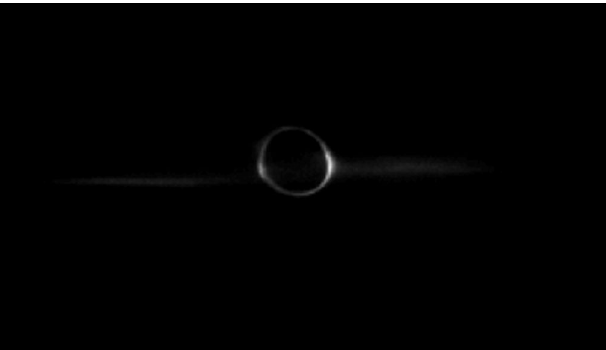
¼ 1 : 15 A with a 100 - (cid:2) m lens